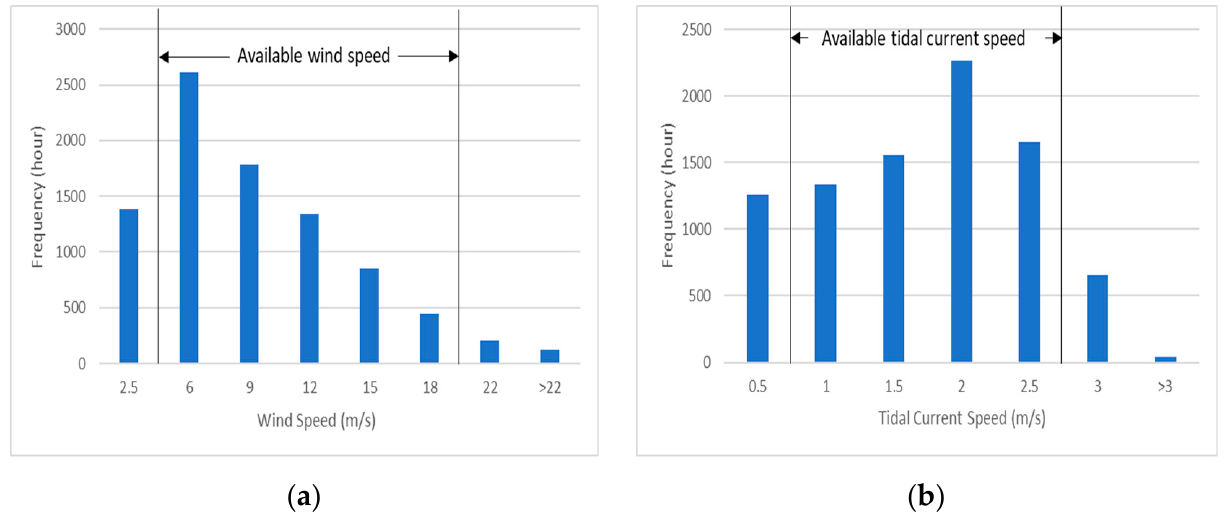
Figure 11. Distributions of ( a ) annual wind speed; ( b ) tidal current speed. Table 2. Parameters of the major components.